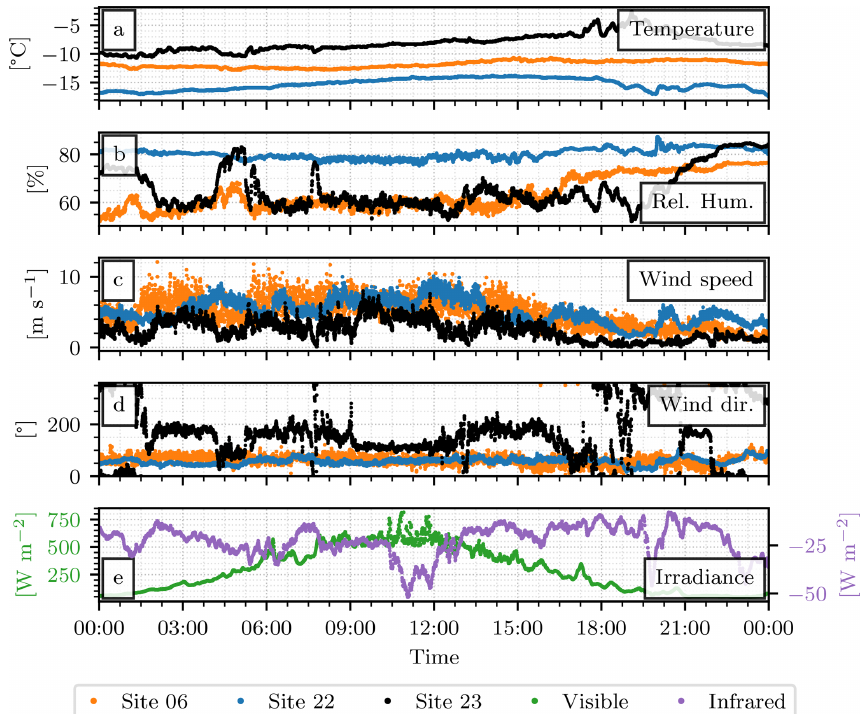
Figure 6. Measurements collected during the precipitation event on the 23 December 2019 by the automated weather stations and radiometers deployed alongside the three MRR-PROs. Four meteorological variables are displayed in the top four panels: temperature (a) , relative humidity with respect to water (b) , wind speed (c) , and direction (d) . The time series at each panel is denoted by a different color: orange for the MRR-PRO 06 site, blue for the MRR-PRO 22 one, and black for the MRR-PRO 23 one. The downwelling irradiance in the shortwave (in green, y axis on the left) and in the longwave (in purple, y axis on the right) recorded by the radiometers co-located with the MRR-PRO 06 are shown in panel (e)